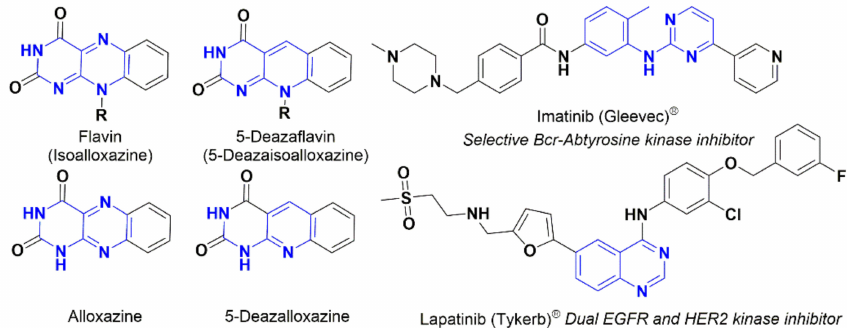
Figure 2. Structures of flavin, 5-deazaflavin, alloxazine, 5-deazaalloxazins and the well-known kinase inhibitors (imatinib and